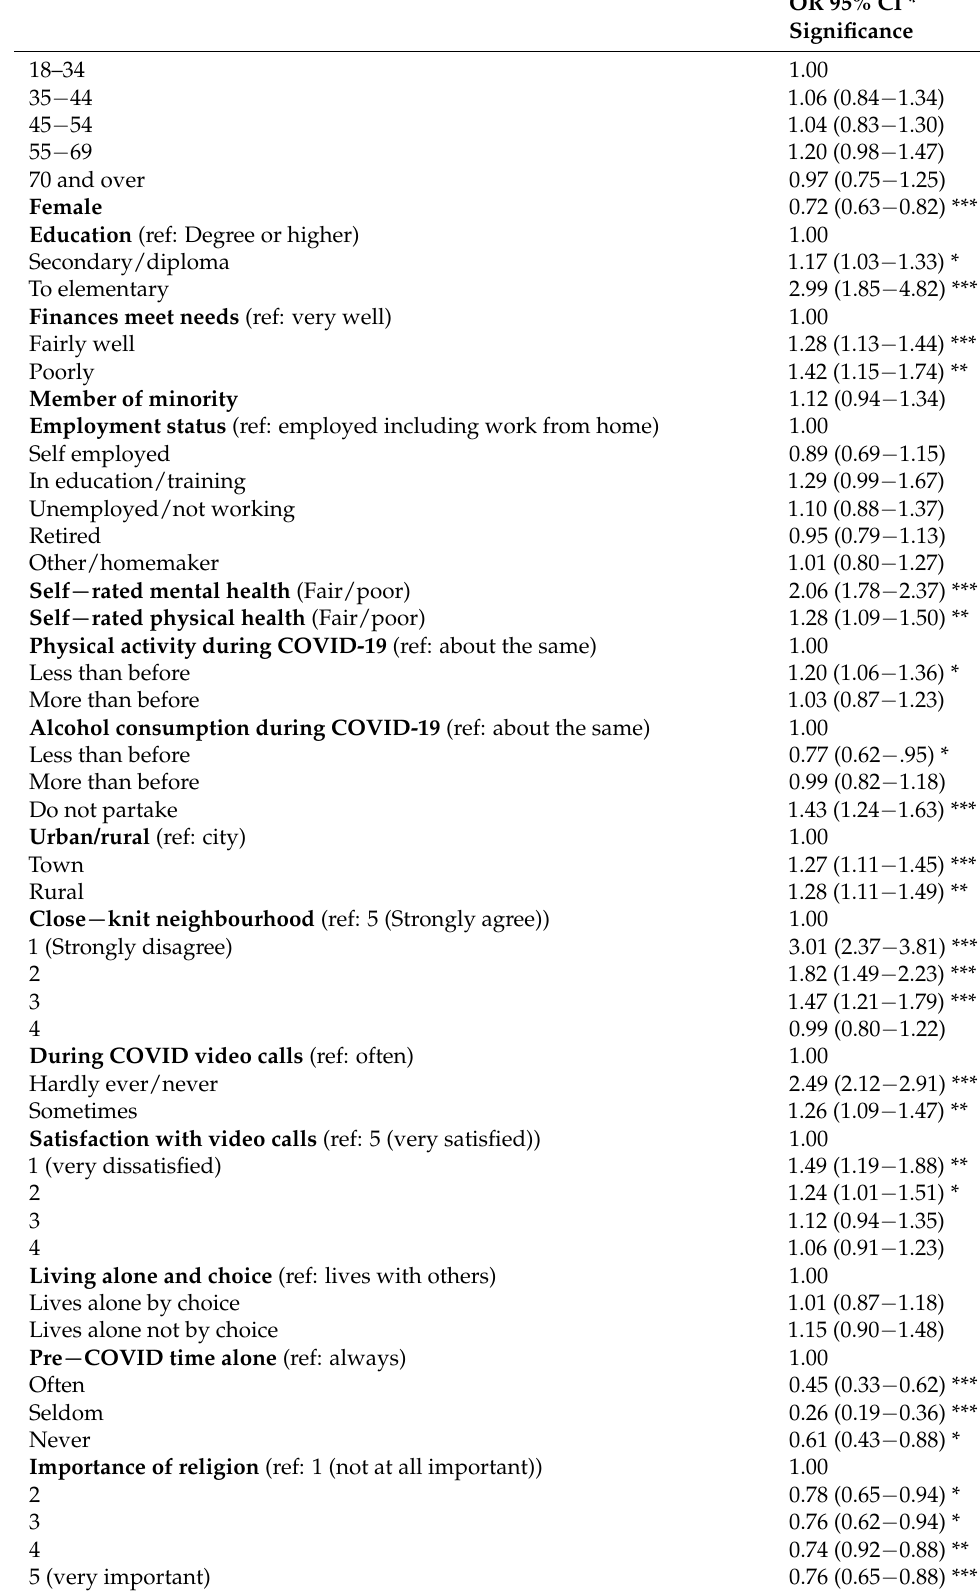
Table 4. Final logistic regression model for isolation pre COVID-19